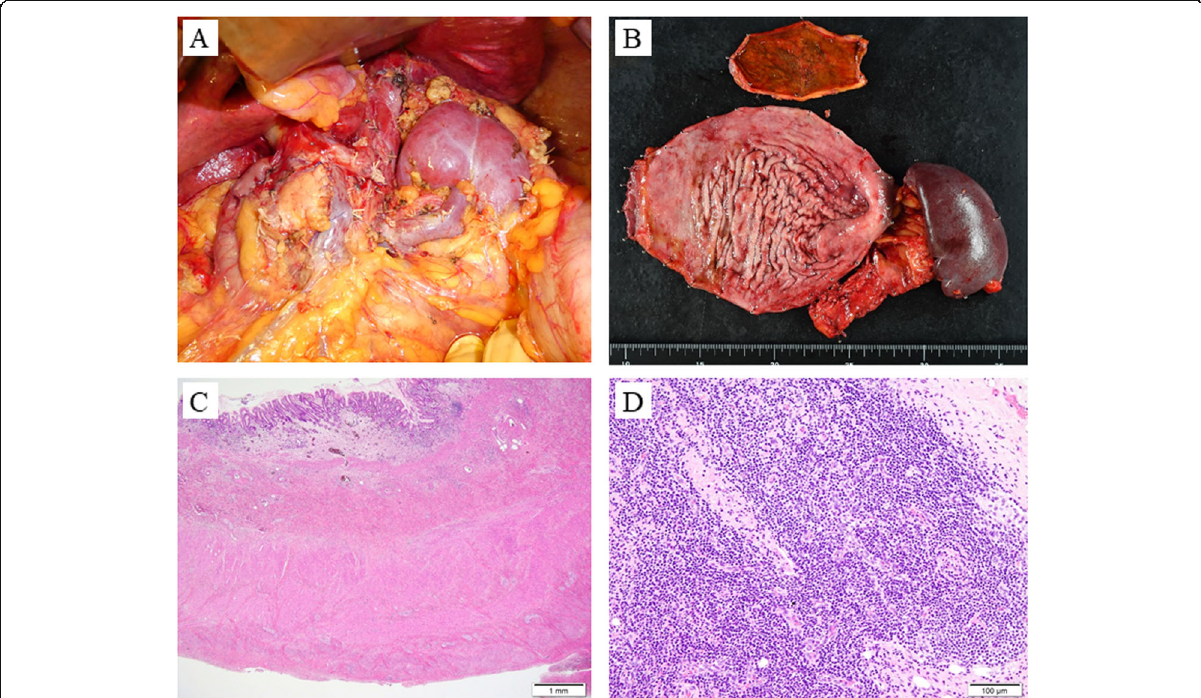
Fig. 4 a Intraoperative image taken after total gastrectomy plus distal pancreaticosplenectomy with para-aortic lymph node (PAN) dissection. b Surgically resected specimen. Macroscopic observation indicated complete regression of the primary lesion. c Histopathological findings of the resected specimen. Atrophy and fibrosis of the gastric mucosa in the lesion area were demonstrated with no infiltration of cancer cells at any site. d There were no signs of residual cancer cells in the resected